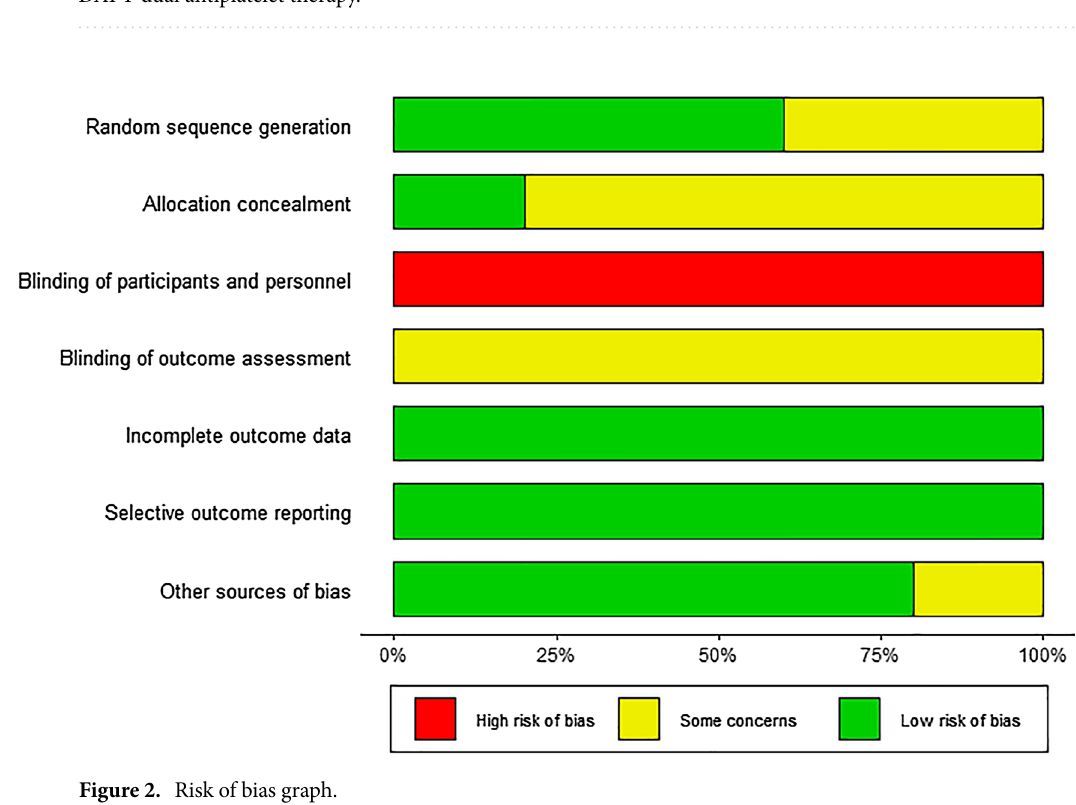
Figure 2. Risk of bias